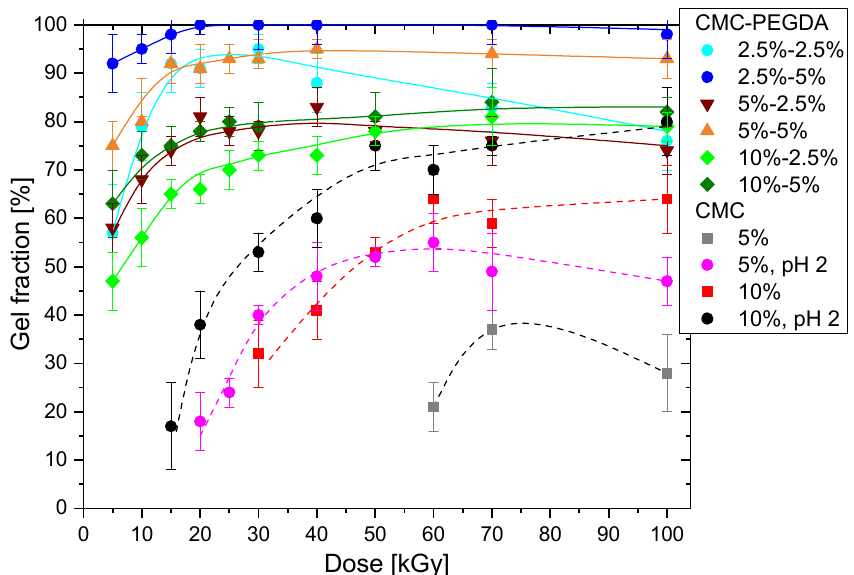
Figure 2. Gel fraction of hydrogels manufactured by the irradiation of CMC and CMC–PEGDA in aqueous solutions.